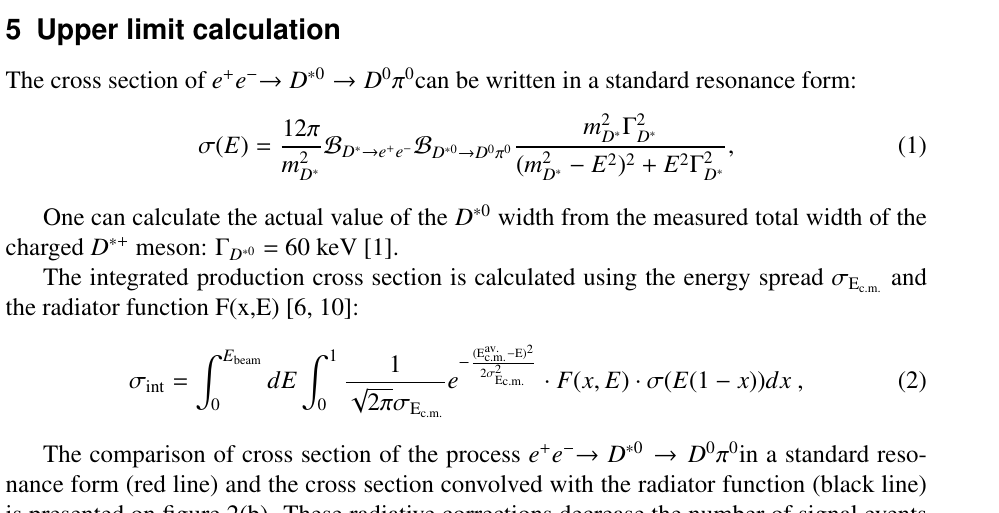
K ± π ∓ and K 0 K ± π ∓ π 0 events b.) The red line — cross section of e + e − S S